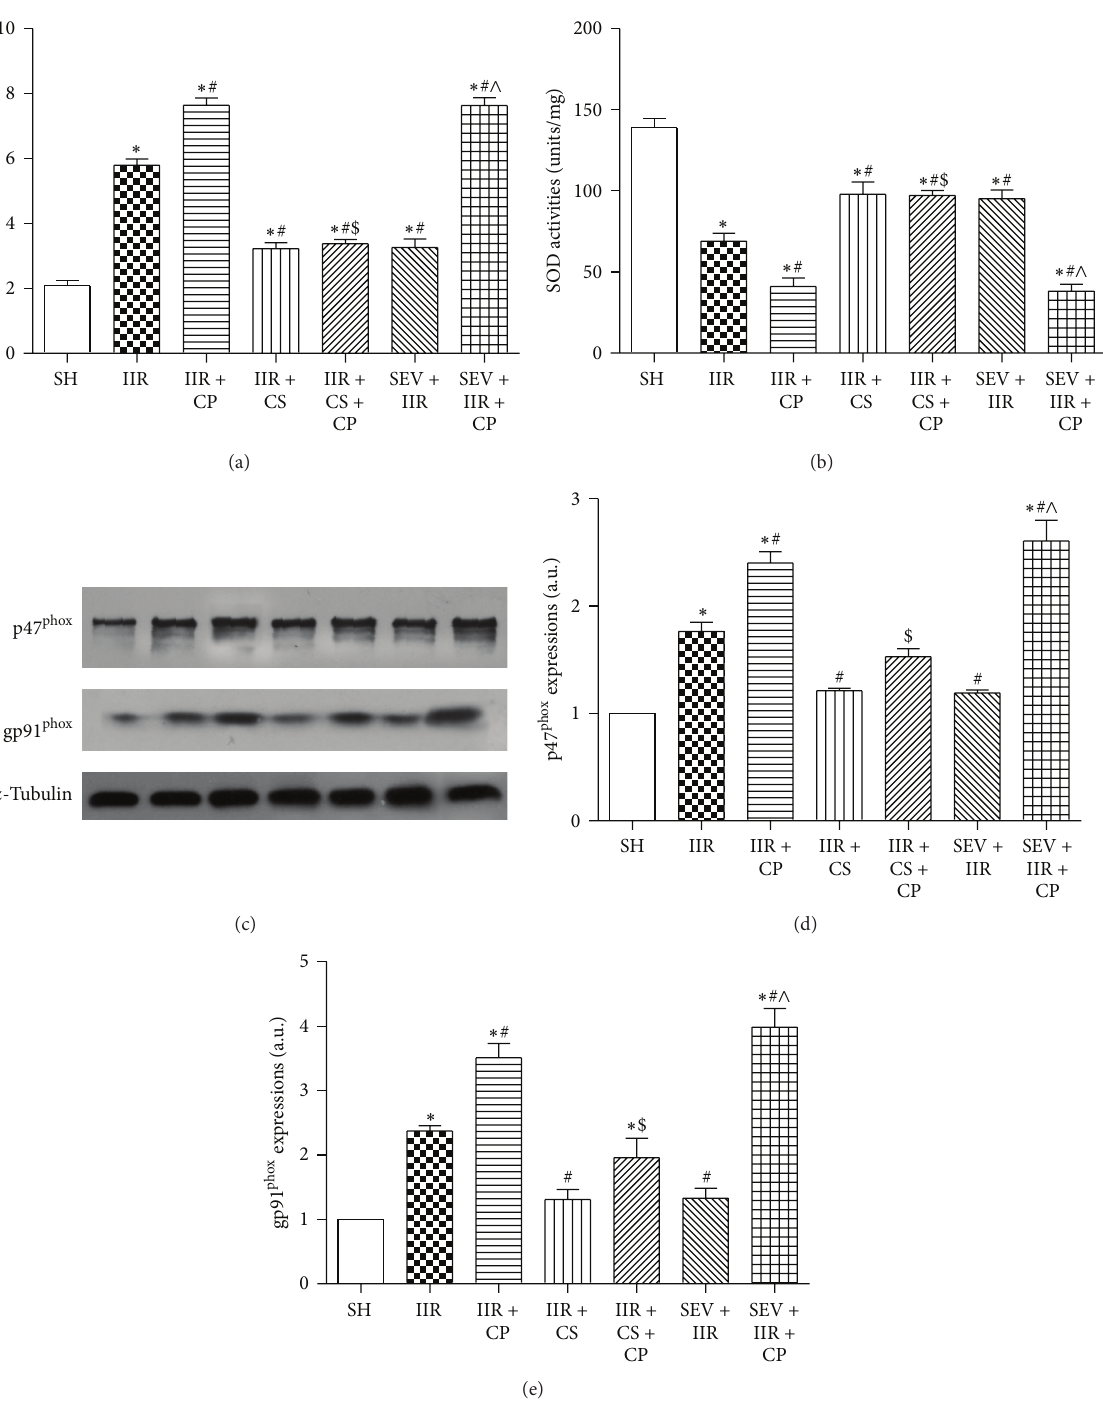
Figure 6: MDA contents and SOD activities and p47 phox and gp91 phox protein expressions in intestine mucosa after IIR injury. SH group (Sham-operated group), IIR group (75 min intestinal ischemia and 2 h reperfusion), IIR + CP group (IIR group + Compound 48/80 1mg/kg), IIR + CS group (50 mg/kg cromolyn sodium treated IIR group), IIR + CS + CP group (50 mg/kg cromolyn sodium treated IIR group + Compound 48/80 1mg/kg), SEV + IIR group (2.3% sevoflurane pretreated IIR group), and SEV + IIR + CP group (2.3% sevoflurane pretreated IIR group + Compound 48/80 1mg/kg). Bar graph (a) quantified MDA contents and bar graph (b) quantified SOD activities, 𝑛 = 6 per group. Representative bands of p47 phox and gp91 phox protein expressions are displayed in (c). Bar graphs (d) and (e) quantified p47 phox and gp91 phox protein expressions, respectively ( 𝑛 = 3 ). Results are expressed as Mean ± SEM. ∗ 𝑃 < 0.05 versus SH group, # 𝑃 < 0.05 versus IIR group, $ 𝑃 < 0.05 versus IIR + CP group, & 𝑃 < 0.05 versus IIR + CS group, and ∧ 𝑃 < 0.05 versus SEV + IIR